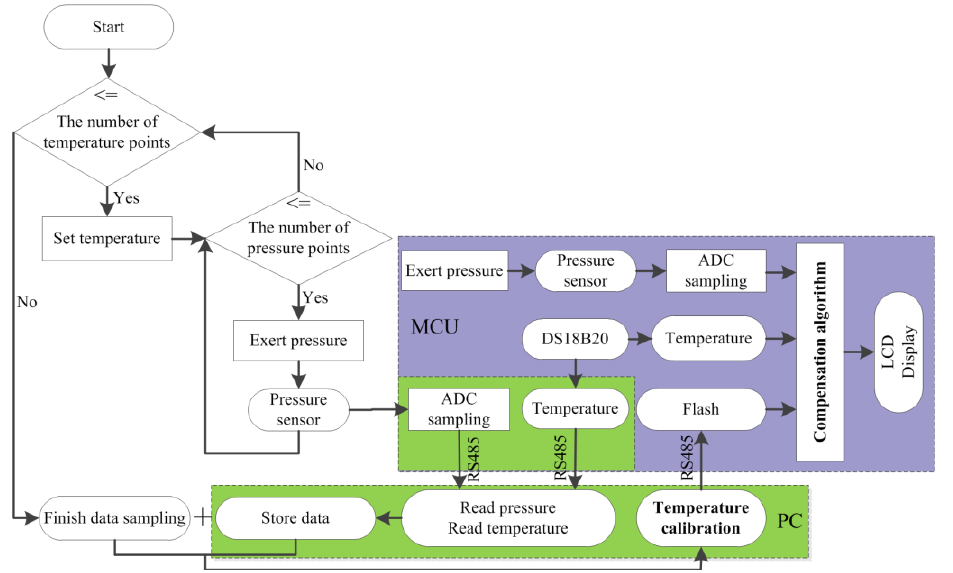
Figure 6. The flowchart of the temperature compensation